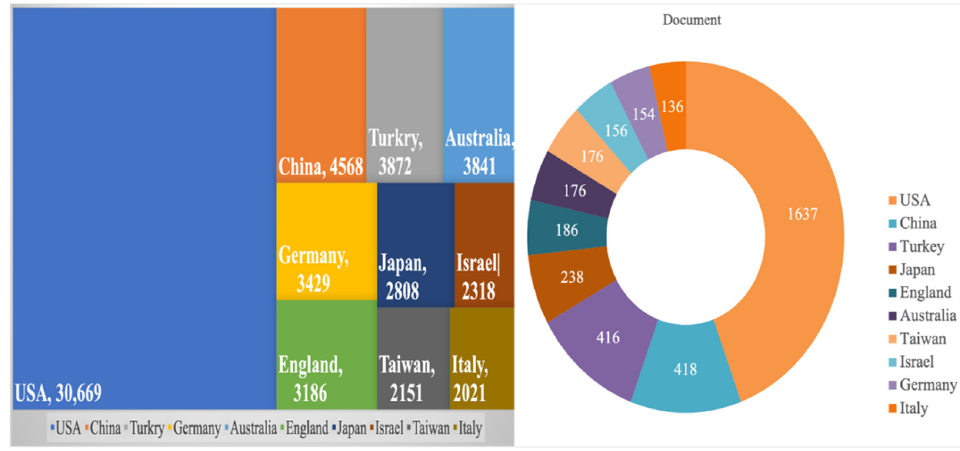
Figure 4. Distribution of the number of publications in each country.